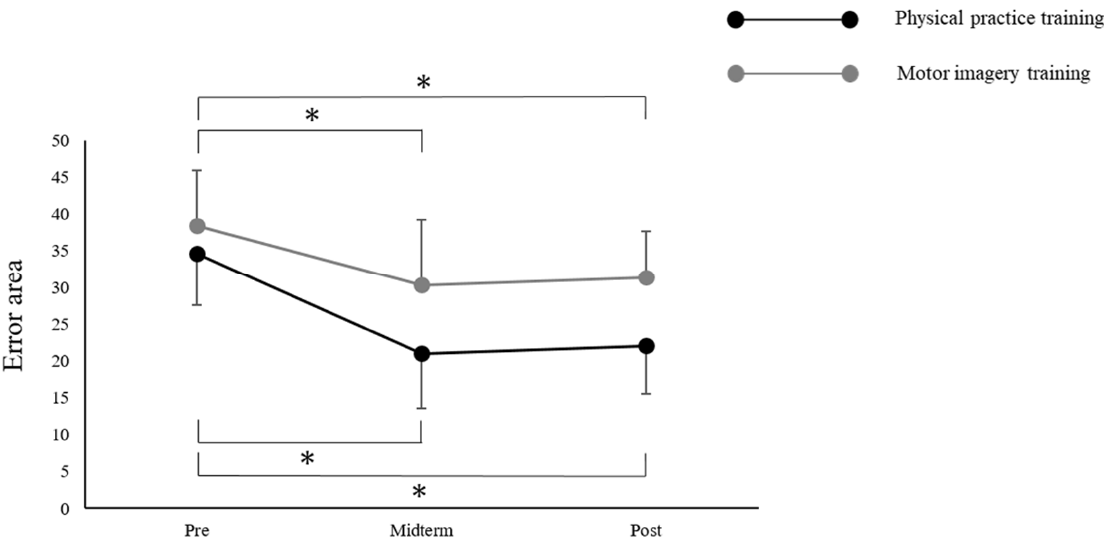
Brain Sci. 2022 , 12 , 1087 Figure 5. Chronological changes in the error area during training. * Significant difference between pre- and mid-terms as well as pre- and post-terms, p < 0.05. Data are expressed as means ± standard errors.